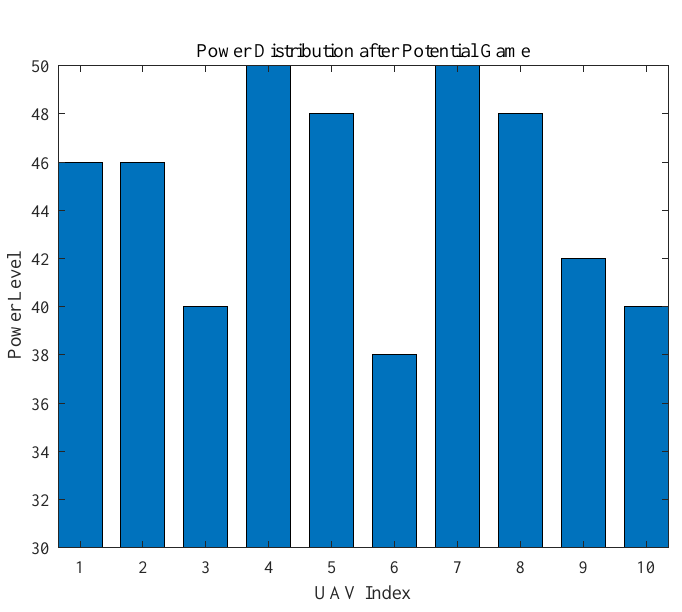
Figure 3. Final Power distribution after